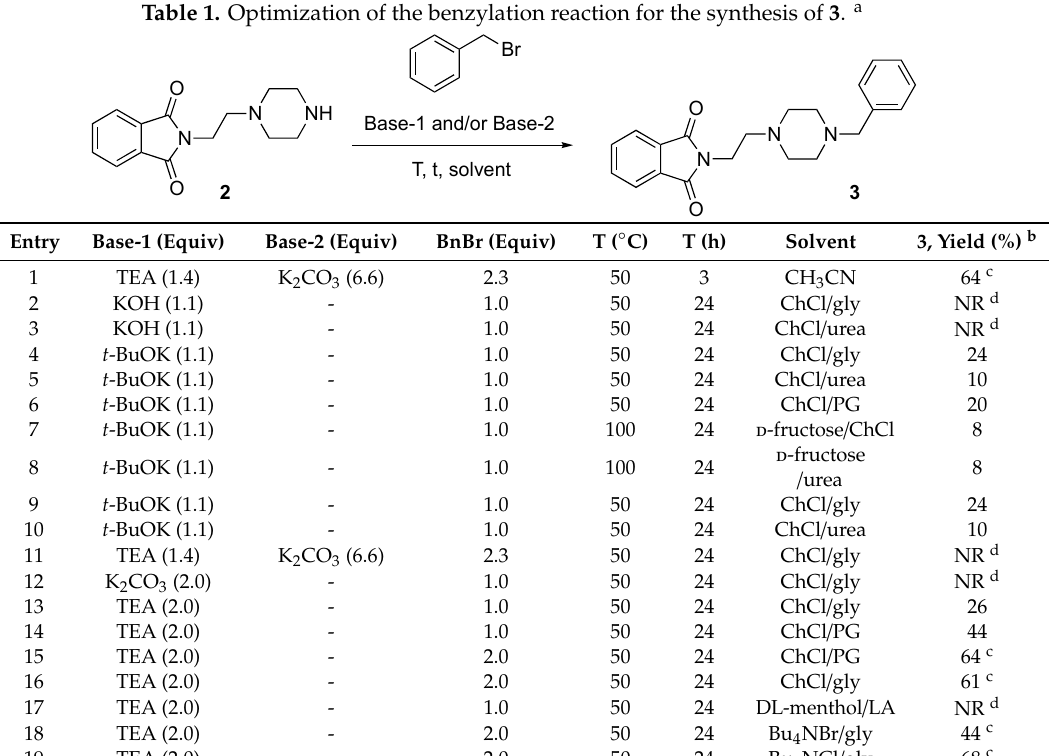
Table 1. Optimization of the benzylation reaction for the synthesis of 3 . a